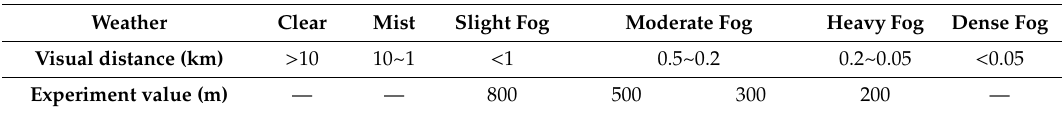
Table 2. Fog level and visible distance set in the experiment.